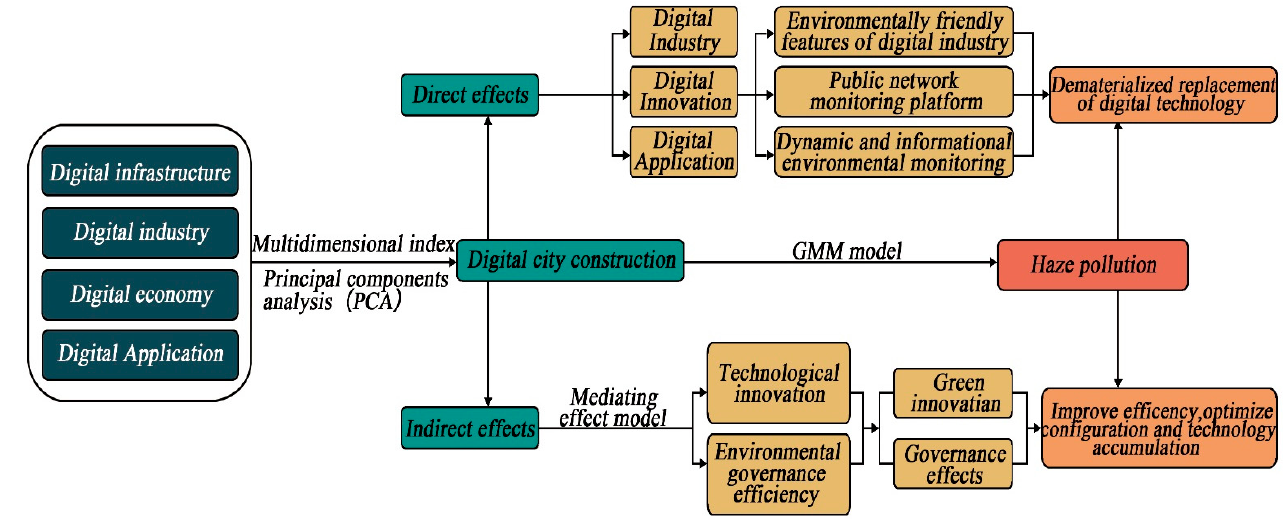
Figure 1. Conceptual framework of the impact of digitalization on haze pollution.